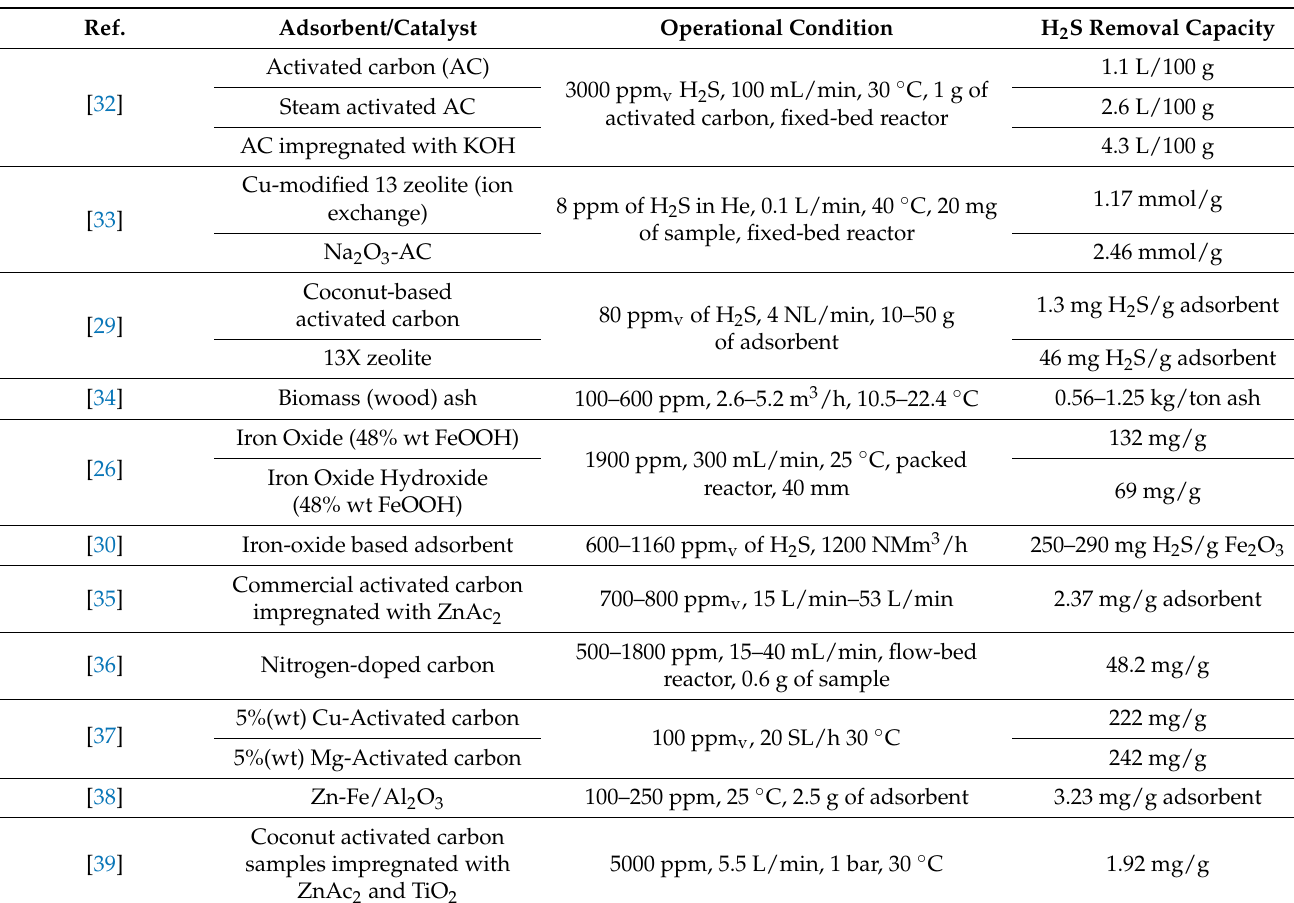
Table 2. Materials and their H 2 S removal capacity described in the literature.